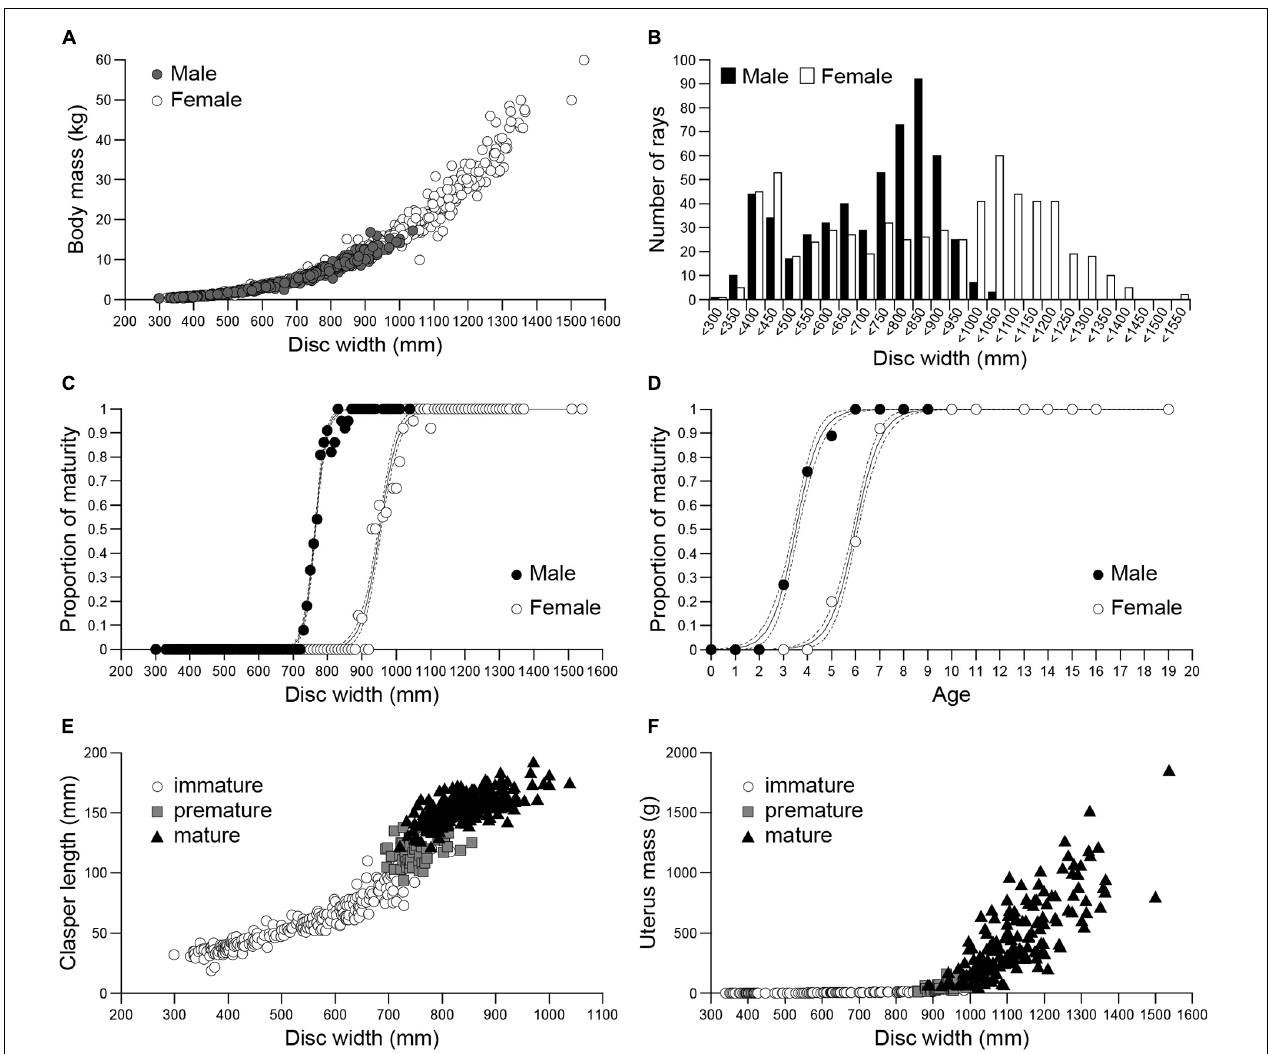
FIGURE 2 | Size, sex, and maturity of Naru eagle rays Aetobatus narutobiei from Ariake Bay. (A) The relationship between the disc width (DW) and body mass (BM) for males (closed circle) and females (open circle). (B) Size class frequencies for males (black bar) and females (white bar). Size at maturity (C) and age at sexual maturity (D) , for males (black circle) and females (white circle). Dashed lines represent 95% confidence intervals; The relationship between disc width and (E) clasper length for Aetobatus narutobiei males and (F) uterus mass for females.